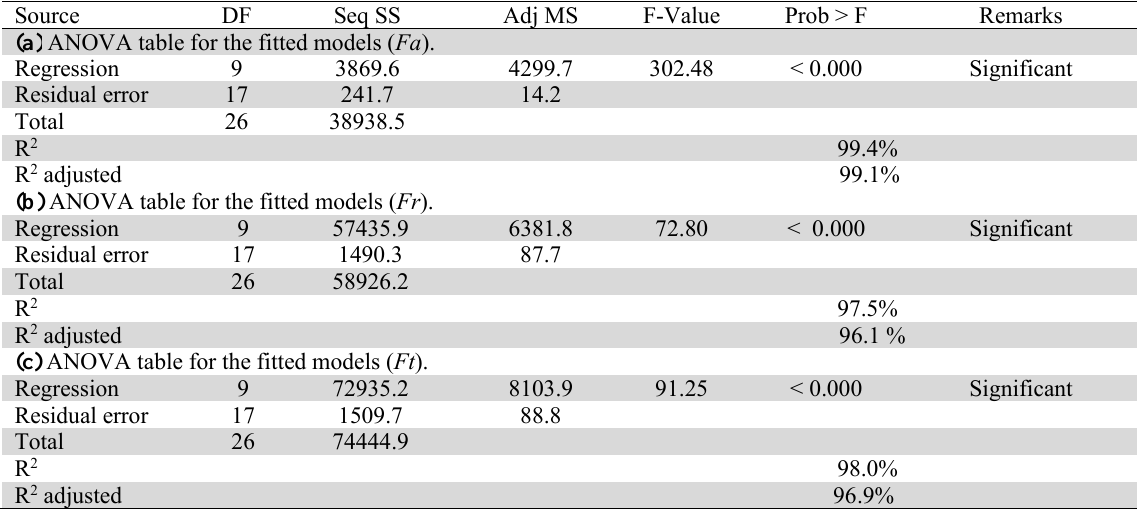
ANOVA table for the fitted models for cutting force components: (a) Fa , (b) Fr and (c) Ft . Source (a) ANOVA table for the fitted models ( Fa ). Regression